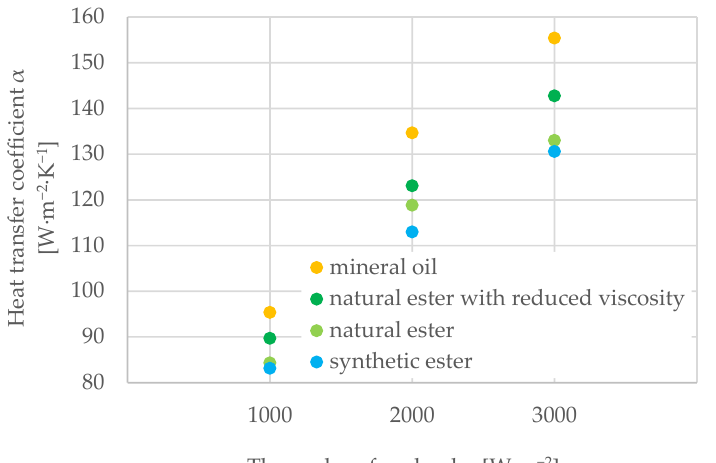
Figure 8. The heat transfer coefficient α depending on the heat load of the cooled surface q for different types of electrical insulation liquid, and the length of the heating element δ = 0.8 m.